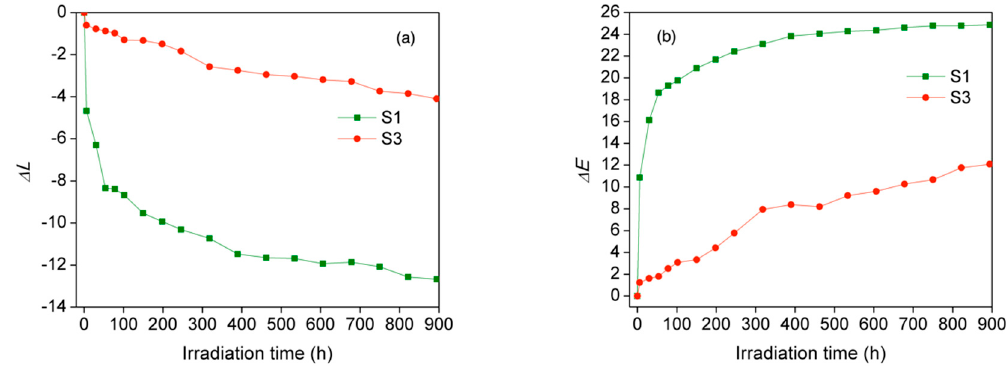
Figure 8. Color changes of ( a ) uncoated wood surfaces and ( b ) epoxy@ZnO coated wood surfaces versus irradiation time; uncoated wood (S1) and epoxy@ZnO coated wood (S3).